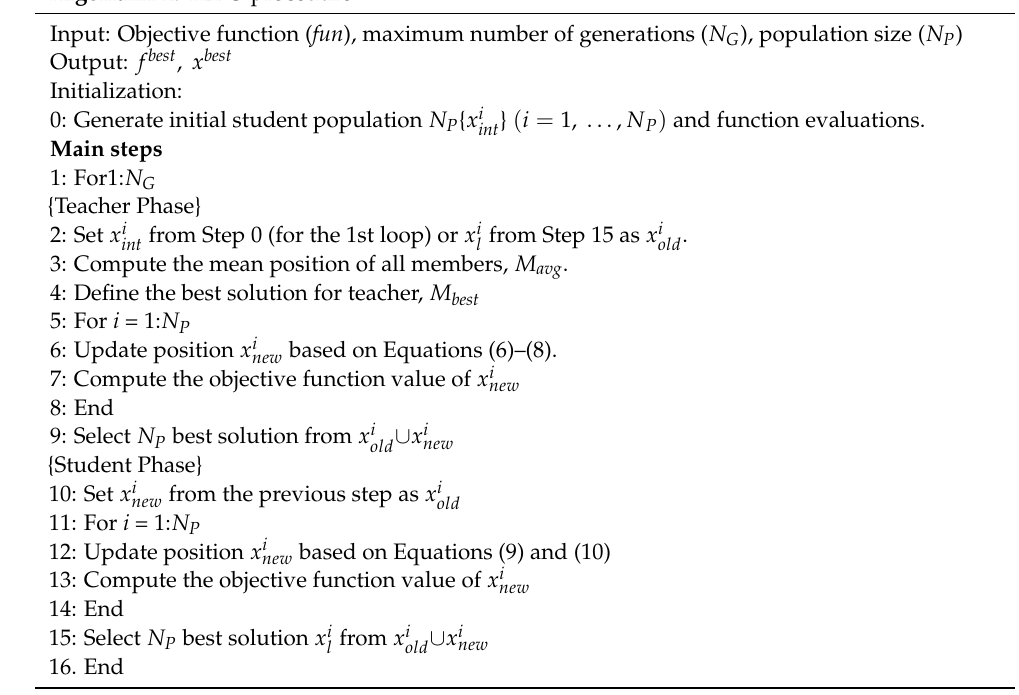
Algorithm 2. TLBO